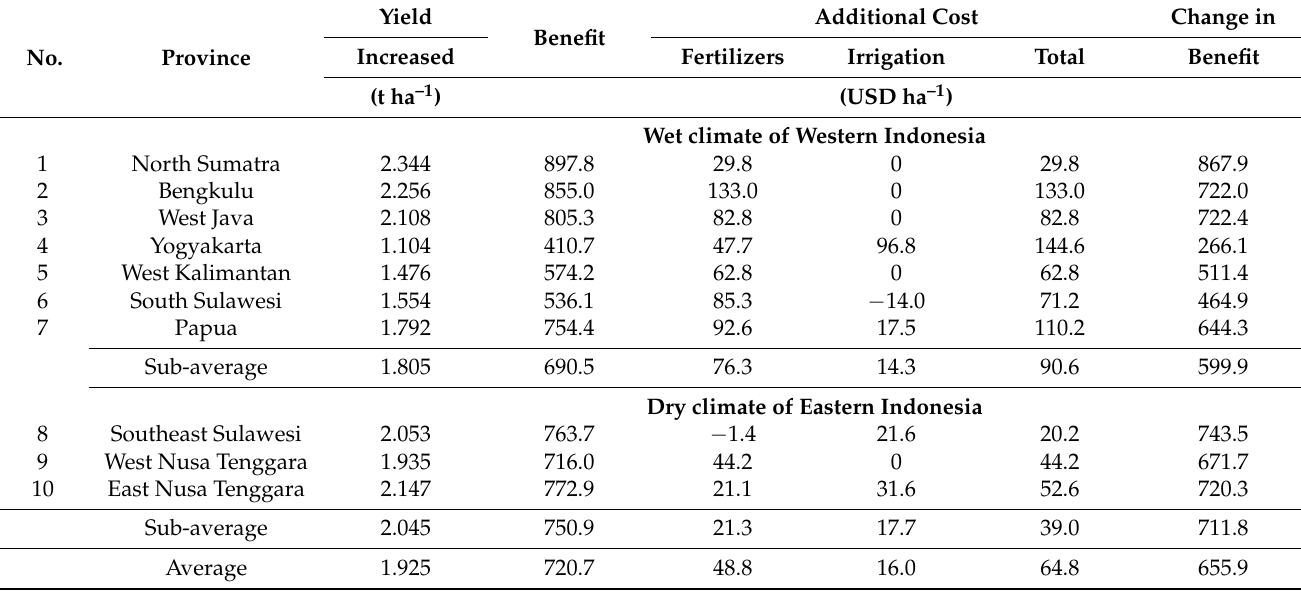
Table 6. Disaggregated profit analysis with recommended practices in rainfed lowlands sorted by the wet climate of western Indonesia and the dry climate of eastern